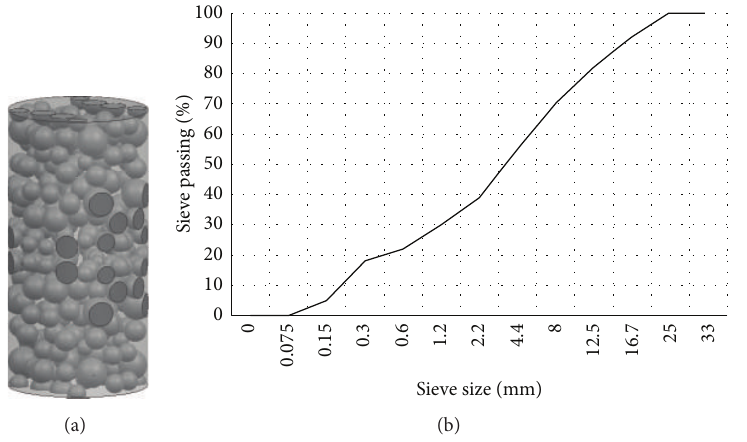
Figure 4: Sample model (a); aggregates distribution (b).